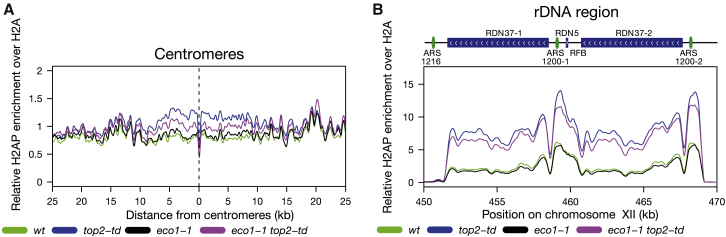
Inactivation of Eco1 Partially Suppresses H2AS129P Enrichment around Centromeres(A) The relative enrichment of H2AS129P over H2A ChIP around all centromeres in eco1-1 cells either with WT expression of Top2 in eco1-1 (black) or depleted of Top2 in eco1-1 top2-td (violet) cells, both released into the cell cycle under the restrictive conditions. Data for WT (green) and top2-td cells (blue) from Figure 1 are shown for comparison. Graph shown is generated from a pile up of the profiles of all centromeres and is an average of two repeats.(B) The relative enrichment of H2AS129P over H2A ChIP across the rDNA repeats in eco1-1 cells either with WT expression of Top2 in eco1-1 (black) or depleted of Top2 in eco1-1 top2-td (violet) cells, all released into the cell cycle under the restrictive conditions. Data for WT (green) and top2-td cells (blue) from Figure 1 are shown for comparison. Graph shown is an average of two repeats.See also Figure S7.